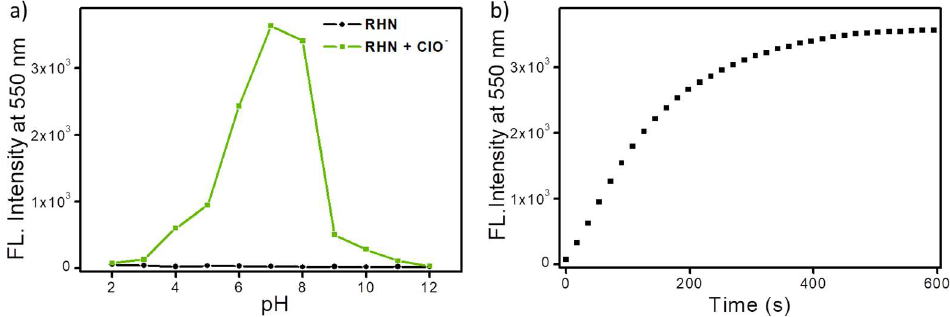
Figure 3. ( a ) Emission spectra response of RHN (10 μM; 10 mM, pH = 7.4, PBS) upon addition of different concentrations of ClO − (0 – 140 μM); Inset: The plot of I 550 versus the equivalents of ClO − ; ( b ) The plot of I 550 versus the concentrations of ClO − (0–30 μM). The conditions: PBS buffer (10 mM, pH = 7.4); λ ex = 500 nm; slits: 10/5 nm. The emission spectra were collected 10 min after the addition of ClO − .